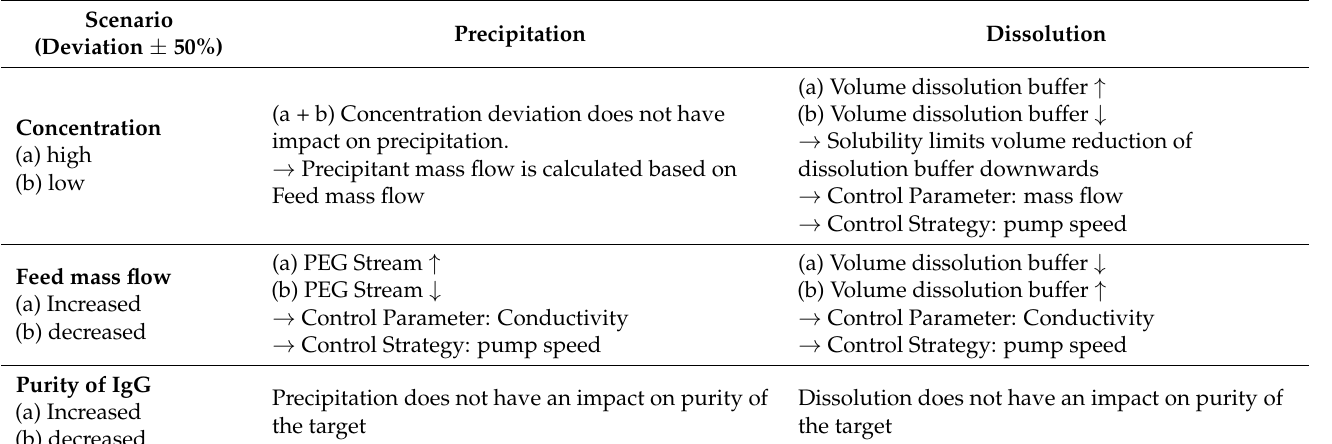
Table 2. Summary of simulations